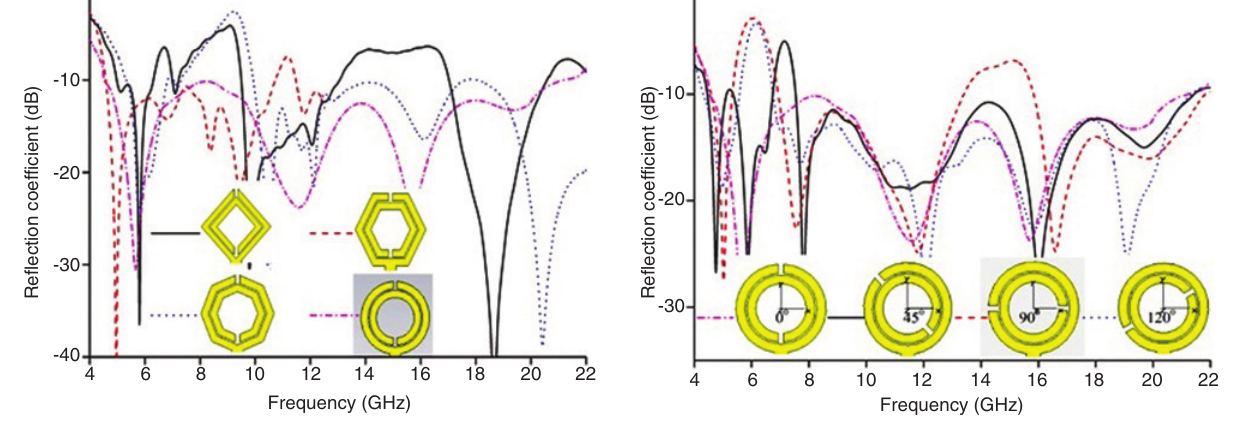
Figure 5: Reflection coefficient for different types of SRR. Figure 6: Reflection coefficient for different position of the SRR